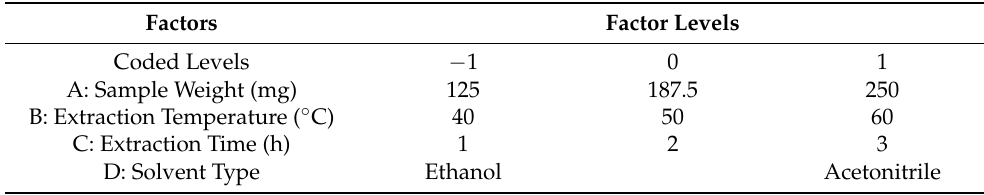
Table 1. Independent factors and their levels used in the response surface